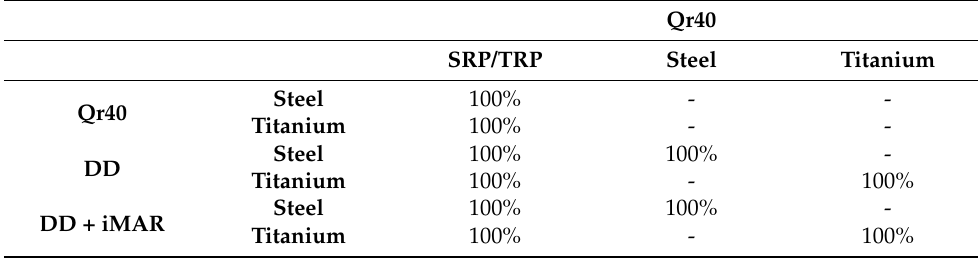
Table 5. The gamma indices obtained from the comparation of dose distributions calculated on the images acquired at 120 kVp, with the acceptability criteria of 2% in dose and 2 mm in space. Each distribution considered in the comparisons was identified by the image on which it was calculated (i.e., by the type of algorithm used to reconstruct it (Qr40, DD, DD + iMAR) and by the type of metal insert placed in the Cheese phantom (titanium, steel, or